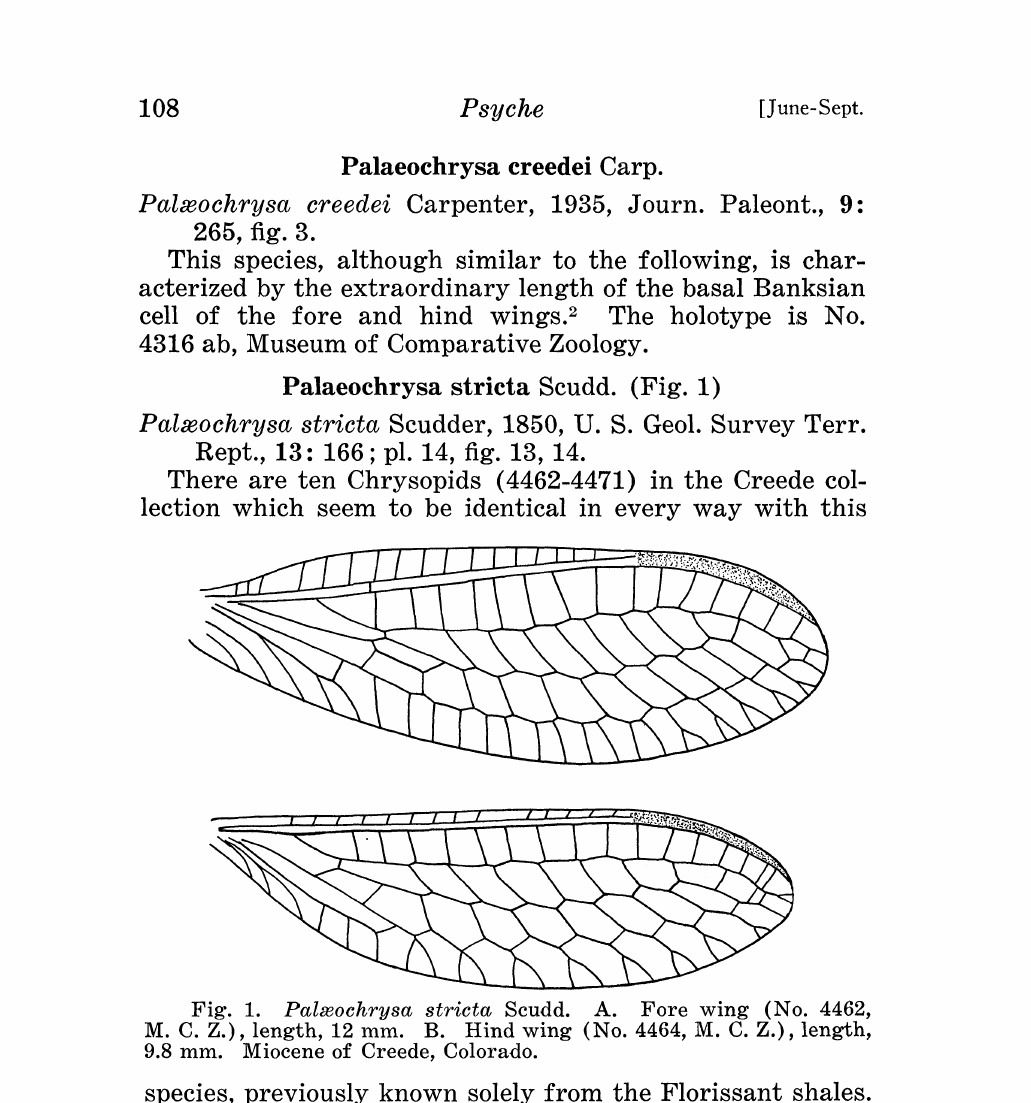
Fig-. 1. Paleochrysa stricta Scudd. A. Fore wing (No. 4462, M. C. Z.), length, 12 mm. B. Hind wing (No. 4464, M. C. Z.), length, 9.8 mm. Miocene of Creede, Colorado. rom the Florissant species, previously known solely